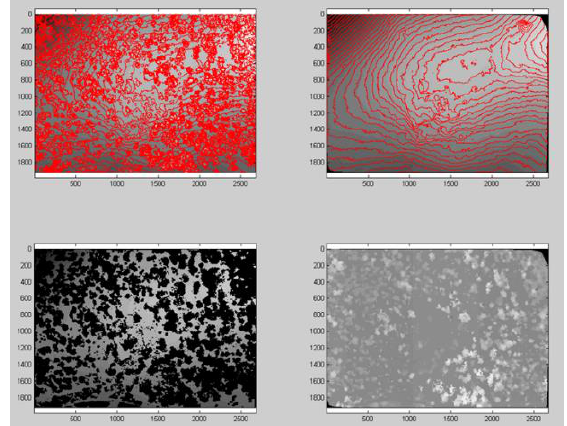
Figure 12: Overlaid Contour lines on the initial DSM (top left), mask (bottom left), 1m contour lines overlaid on the derived DTM (top right) and nDSM (bottom right);